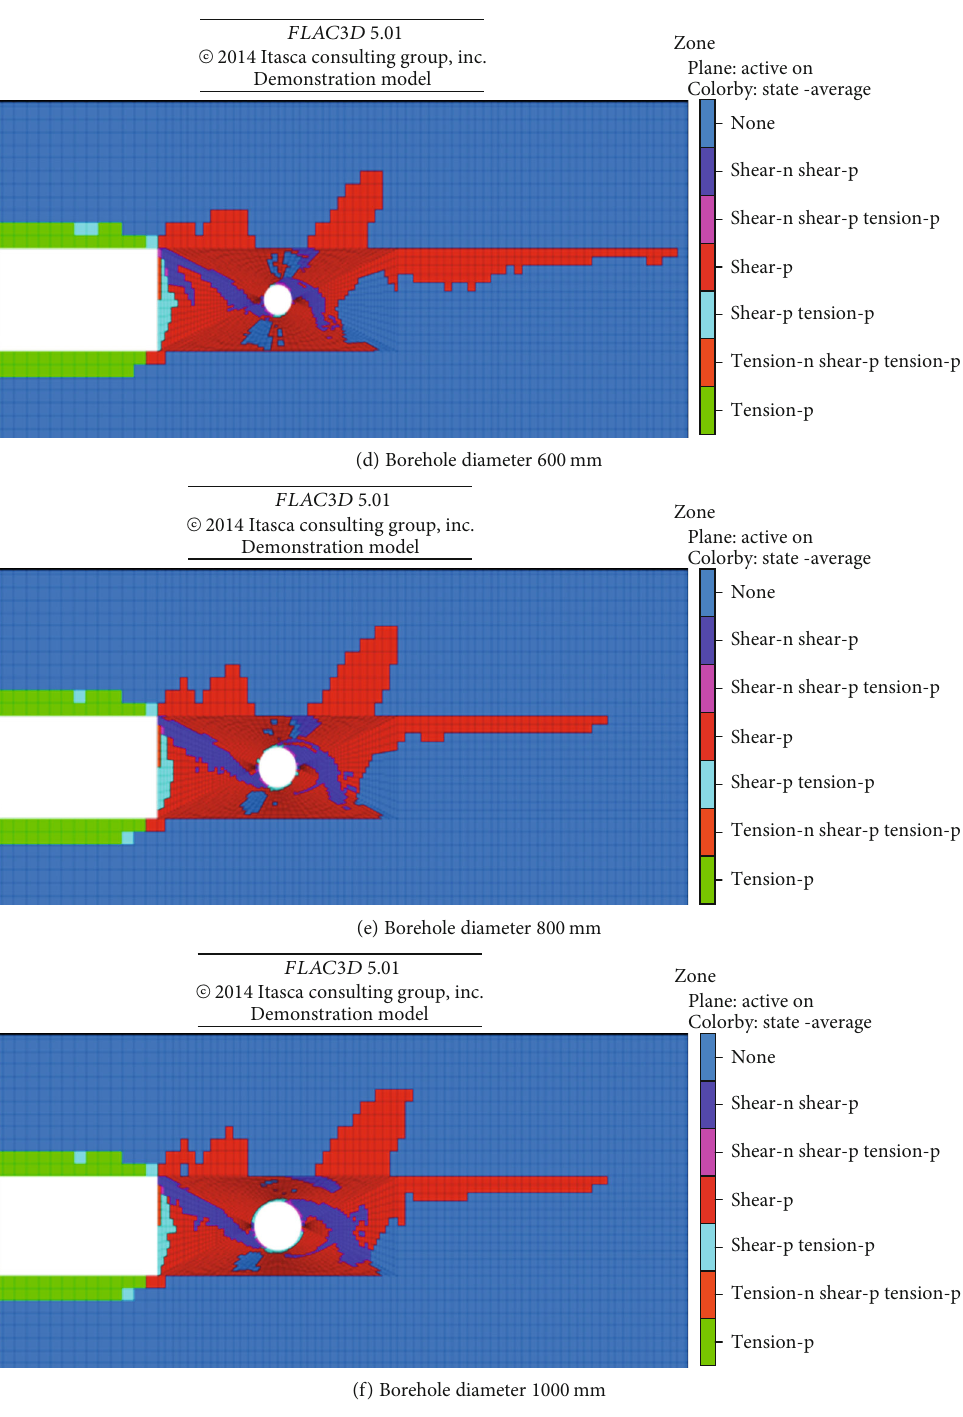
Figure 15: Distribution of plastic zone under di ff erent